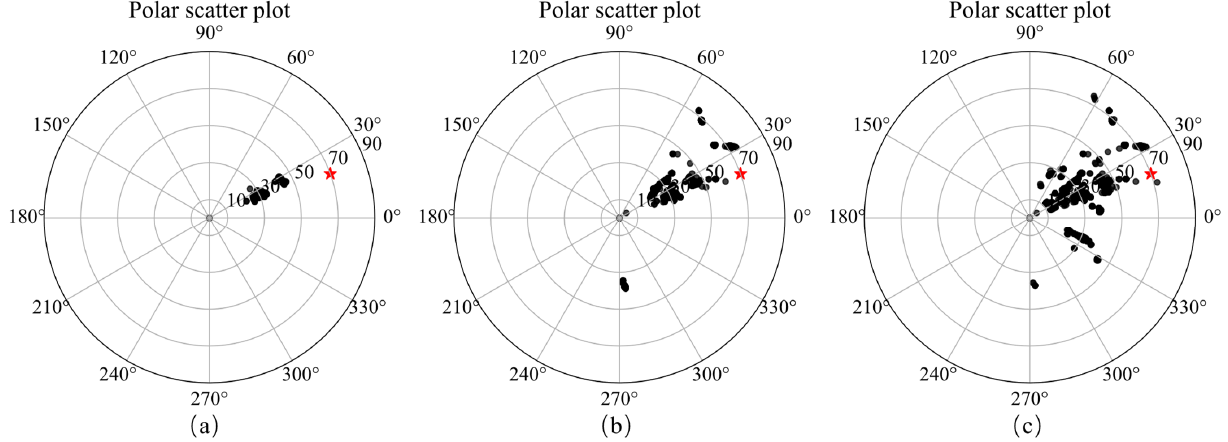
Figure 18. Polar scatter plots showing inverted magnetic inclination (radial) and declination (axial) with large ( a ), medium ( b ), and small ( c ) cutoff values and the result of Liu [17] in red star.